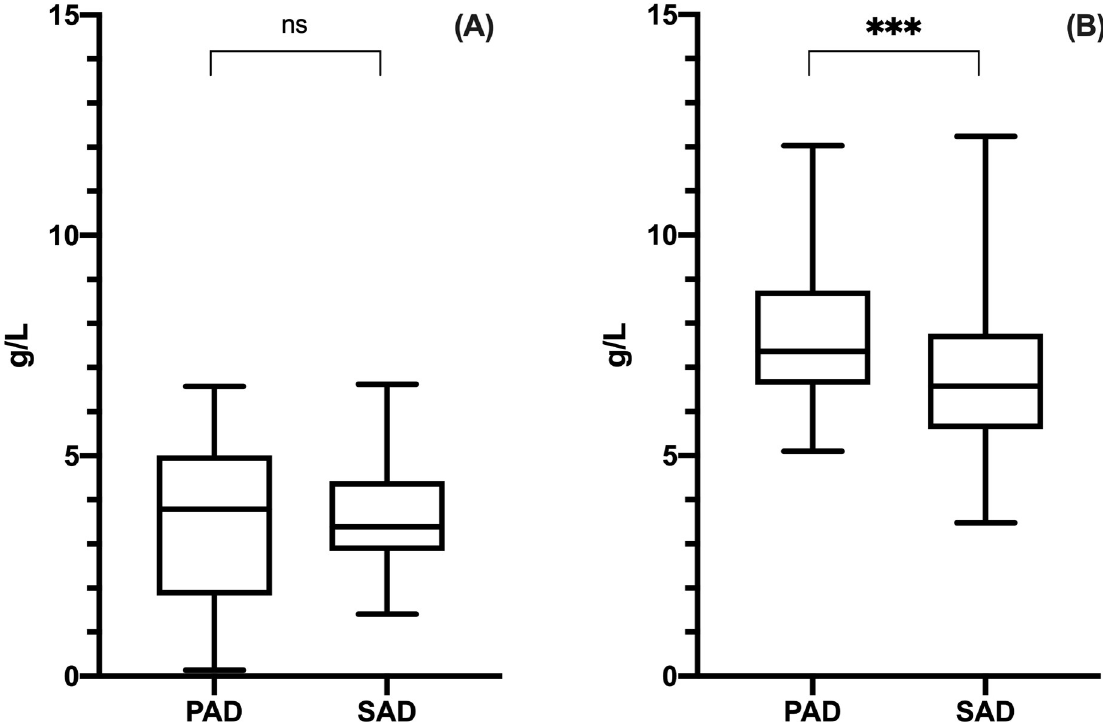
Fig 3. IgG at baseline and trough levels in PAD and SAD patients. Only patients who were na ï ve to Ig therapy were included in the analysis. There was no statistic significant difference in IgG levels before SCIG (panel A) between PAD and SAD patients, whereas, at the steady state (panel B), PAD patients achieved statistic significant higher trough levels as compared to SAD patients. Levels of significance for comparison by Mann Whitney test (A) and unpaired t test (B): ns, not significant, � p � .05, �� p � .01, ��� p � .001, ���� p �